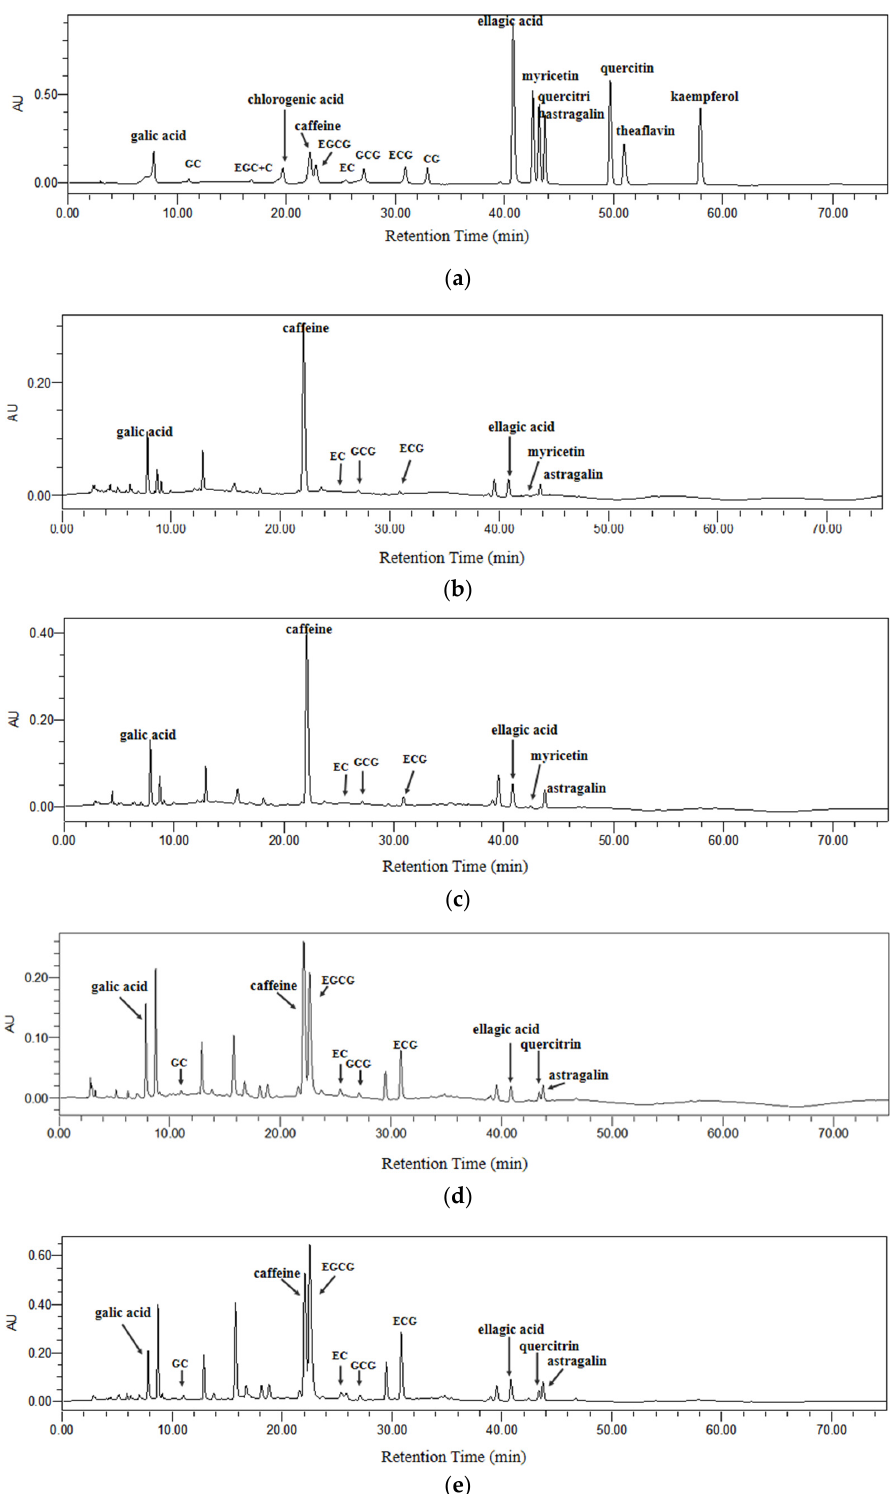
Figure 5. The chromatograms of kombucha produced by fermentation with or without tea residue using HPLC-PDAD at 245 nm. ( a ) standards, ( b ) kombucha from black tea without tea residue, ( c ) kombucha from black tea with tea residue, ( d ) kombucha from green tea without residue, and ( e ) kombucha from green tea with tea residue. C, catechin; CG, catechin gallate; EC, epicatechin; ECG, epicatechin gallate; EGC, epigallocatechin; EGCG, epigallocatechin gallate; GC, gallocatechin; GCG, gallocatechin